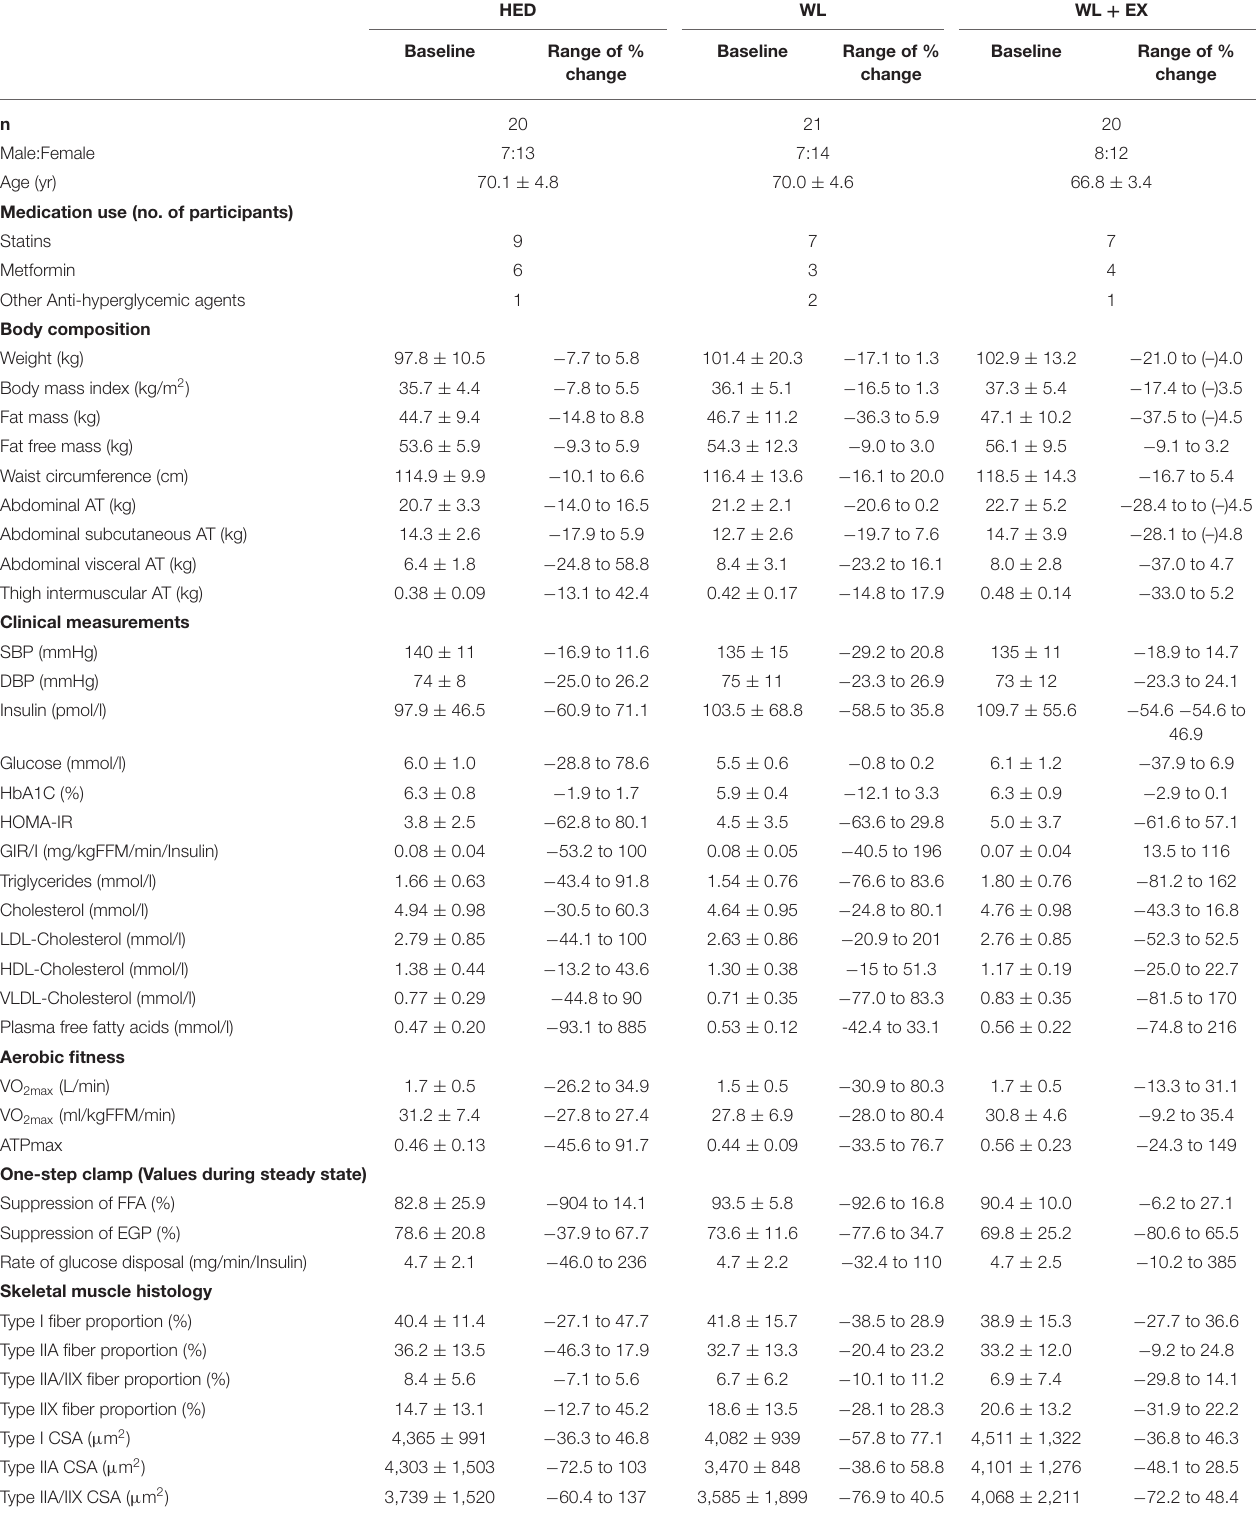
TABLE 1 | Baseline participant characteristics (mean ± SD) and range of change following intervention